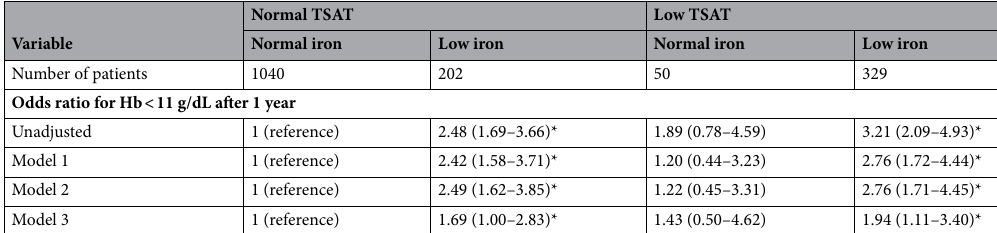
Table 5. Association of TSAT and serum iron with anemia after 1 year in patients without anemia. Model 1 adjusts for Age, Gender, eGFR, UPCR log. Model 2 adjusts for covariates in model 1 plus Diabetes mellitus, Cardiovascular disease, Severe liver disease, Cancer, Mean BP, and Body mass index. Model 3 adjusts for covariates in model 2 plus baseline Hemoglobin, Albumin, CRP log, Ferritin Log, and Phosphorus. *Meant statistically significant compared with reference